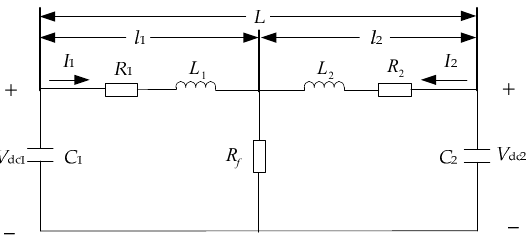
Figure 3. Equivalent circuit diagram of capacitance discharge in pole ‐ to ‐ ground short ‐ circuit fault.